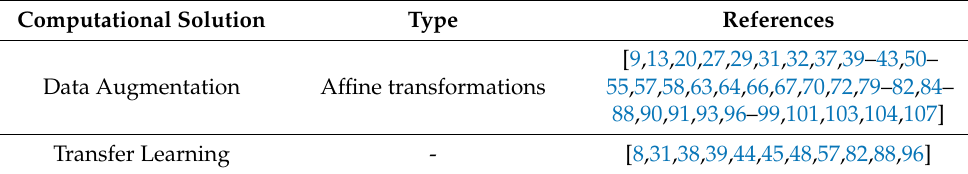
Table 2. Computational solutions to manage small sample datasets.